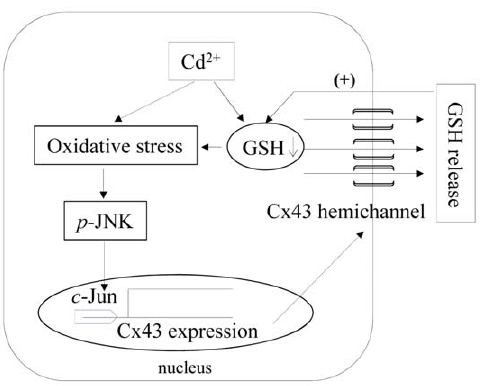
Figure 8. Schematic diagram illustrating Cx43 hemichannel- mediated self-regulation of Cx43 under the stimulation of Cd 2 + . Induction of oxidative stress and depletion of GSH by Cd 2 + results in the opening of Cx43-hemichannels, leading to the efflux of the major antioxidant GSH. The loss of GSH exaggerates oxidative stress, promoting JNK activation and JNK-mediated Cx43 mRNA expression. The increased synthesis of Cx43 might enhance the formation of nonjunctional hemichannels, further worsening the loss of GSH. The vicious autoregulation loop between GSH and hemichannels provides a molecular mechanism for the hemichannel-mediated regulation of Cx43.